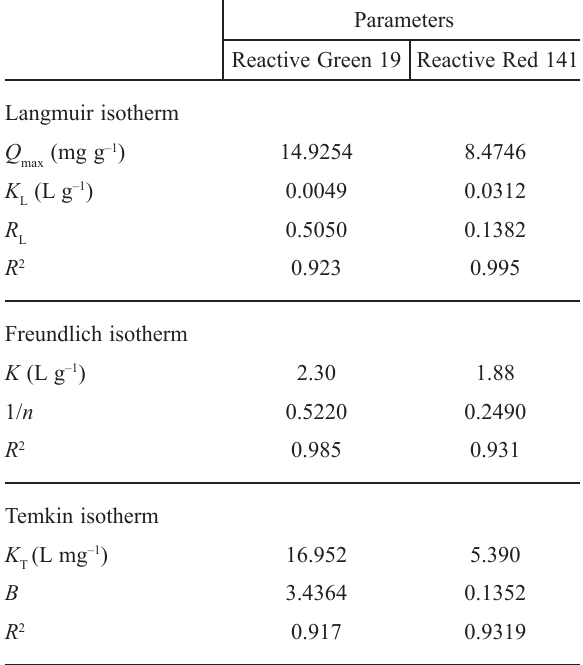
Table 4 – Adsorption isotherm constants and coefficients